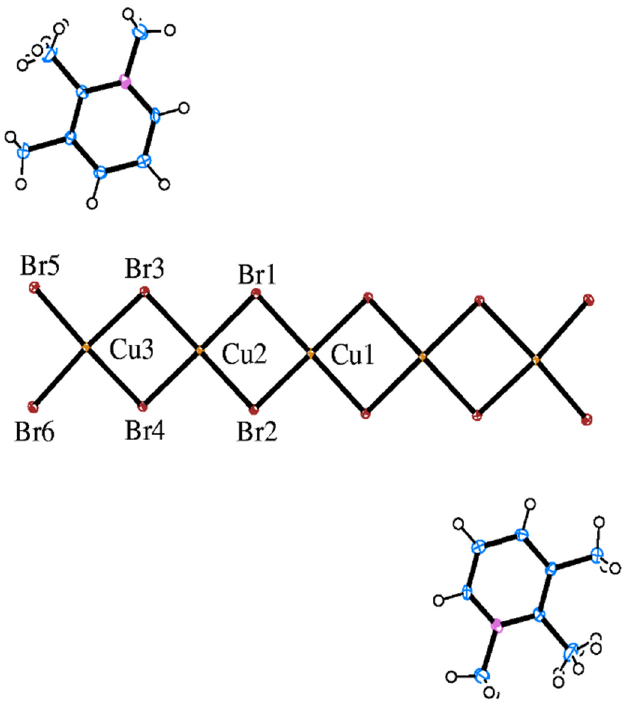
Figure 1. ORTEP diagram (50% ellipsoids) of the formula unit of the (1,2,3-trimethylpyrindium) 2 Cu 5 Br 12 structure with atom labels for the symmetry unique heavy atoms. H-atoms are drawn as spheres of arbitrary radii, and only one component of the disordered organic cation is shown.